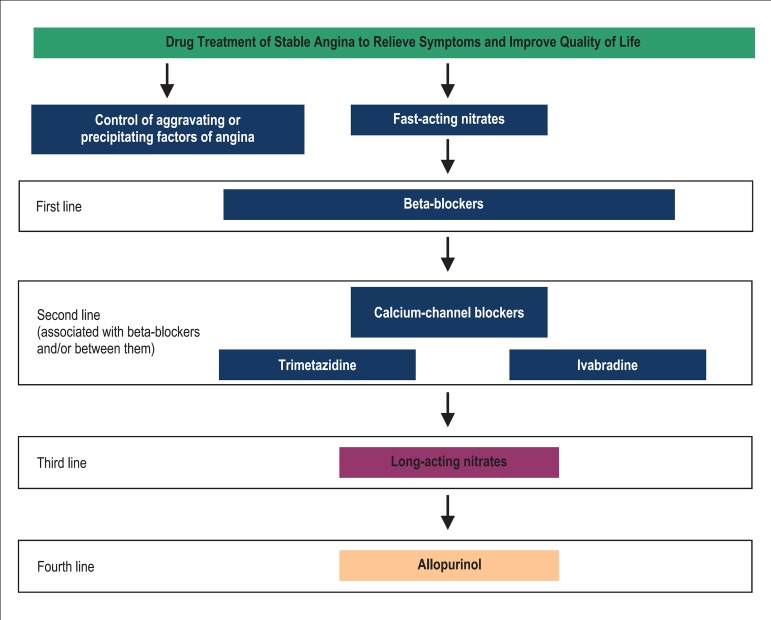
Algorithm for drug treatment of stable angina with antianginal drugs to relieve
symptoms and improve quality of life. Details, levels of recommendation and
evidence level: see the corresponding text.